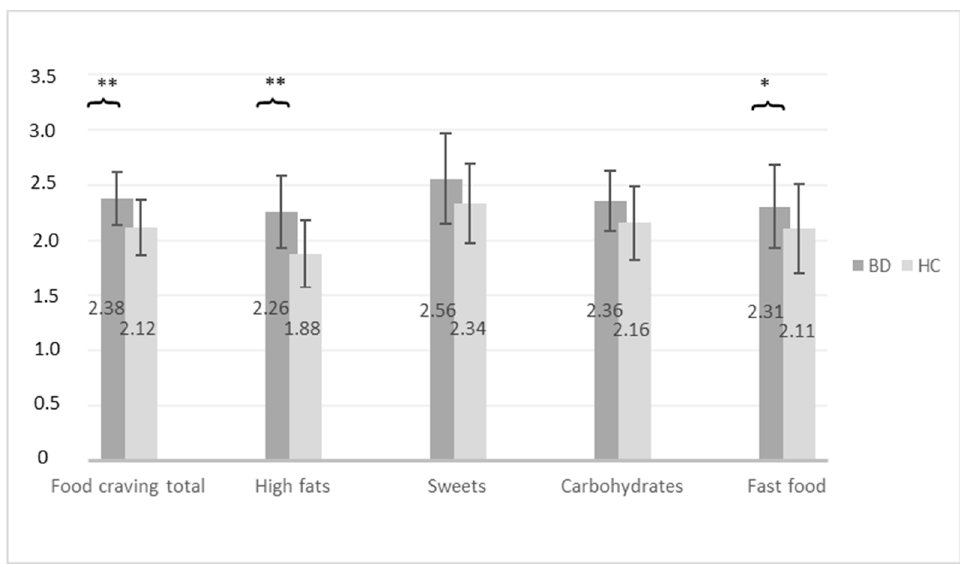
Figure 1. Differences in food craving between individuals with BD and HC (* p < 0.05, ** p < 0.01). Abbreviations: Bipolar disorder (BD), healthy controls (HC).